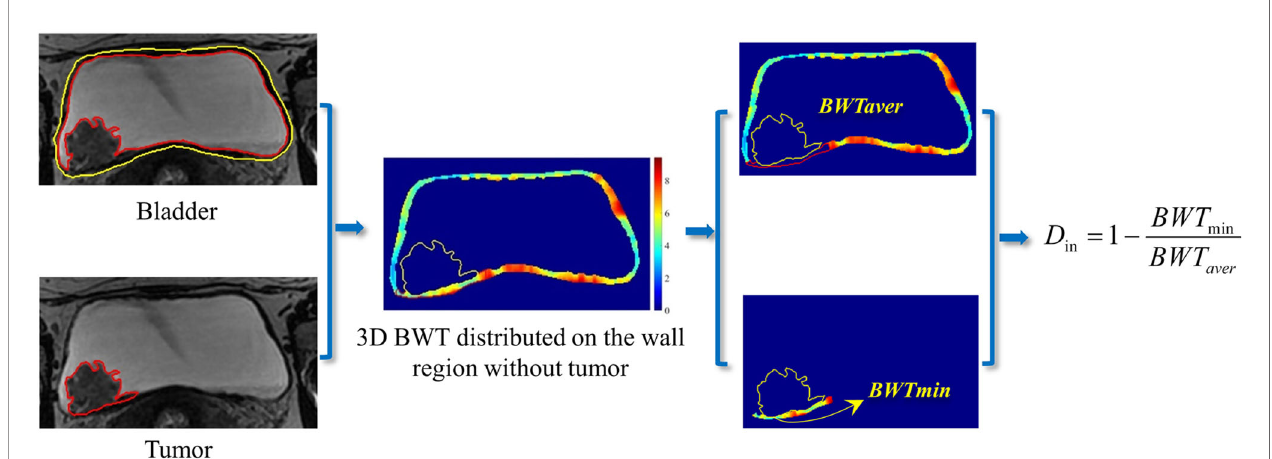
FIGURE 6 | A potential de fi nition of the invasive depth of bladder tumor based on the BWT distribution on the bladder wall